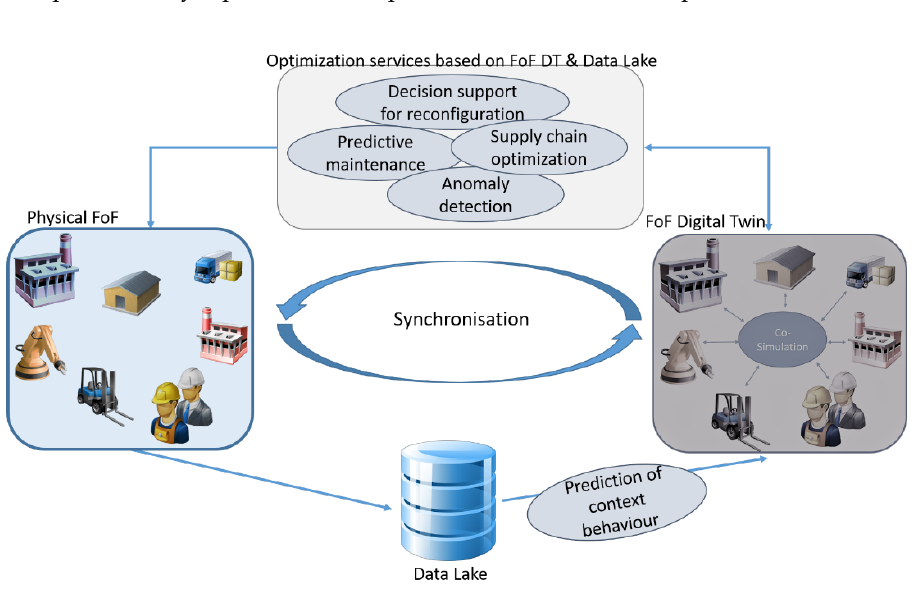
Figure 6. Optimization using the Digital Twin.